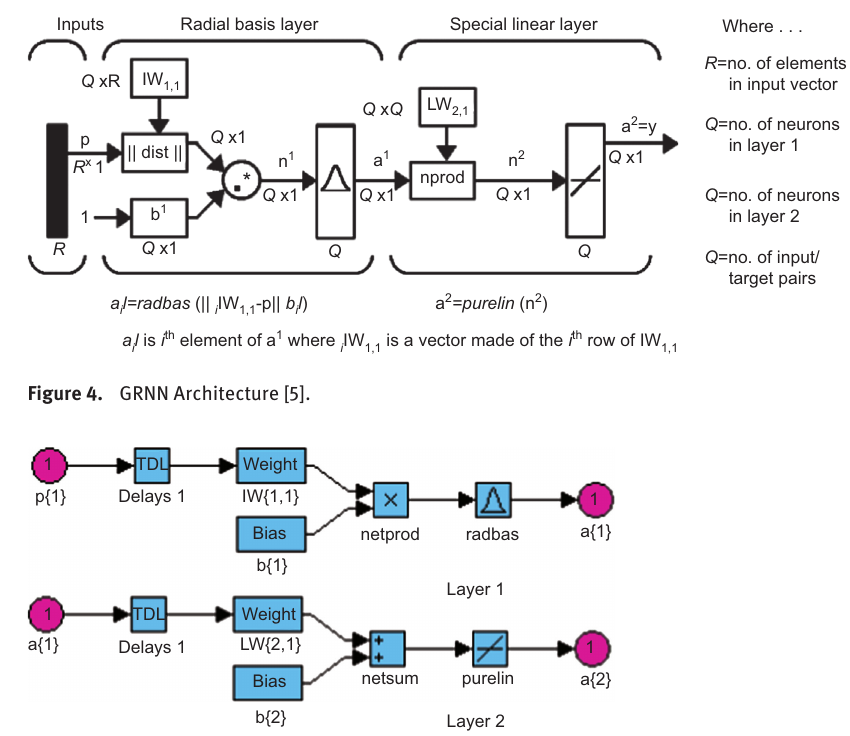
Figure 5. Simulink Model of